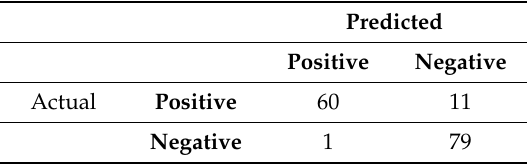
Table 3. Confusion matrix for the prediction model.